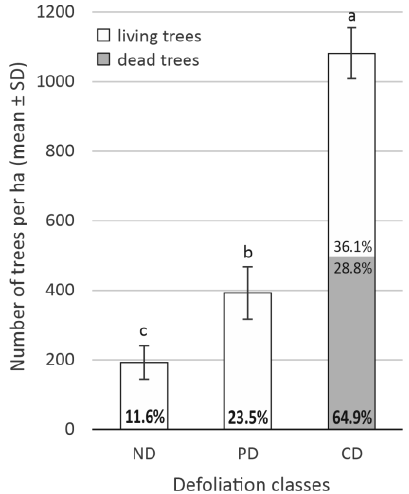
Figure 7. Distribution of the average number of trees per ha according to defoliation classes. ND—non-defoliated trees; PD—partially defoliated trees; CD—completely defoliated trees. Bars with different lowercase letters indicate significant differences according to Tukey’s multiple comparison test ( p < 0.05).